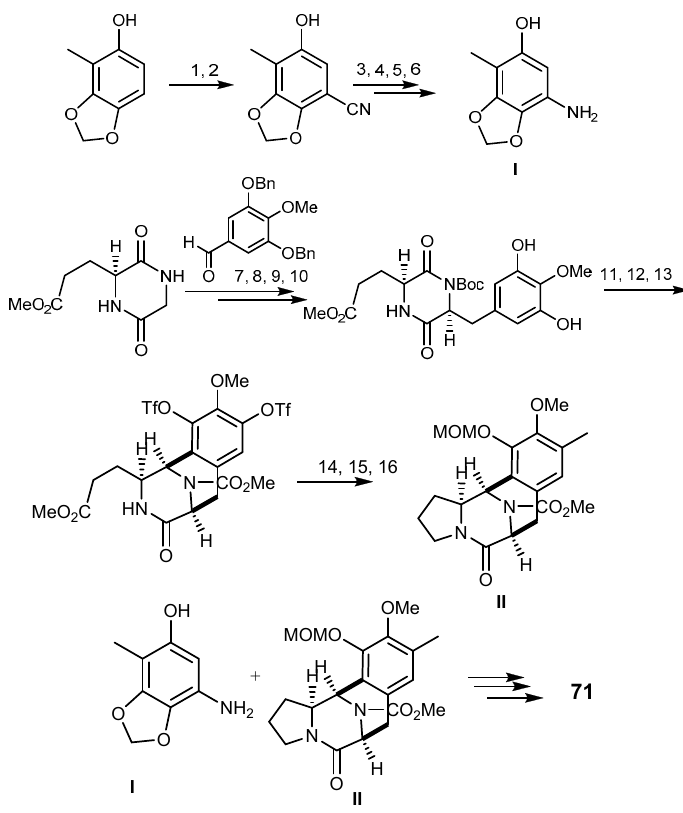
Figure 14. Structure of nocardioazine A ( 73 ).